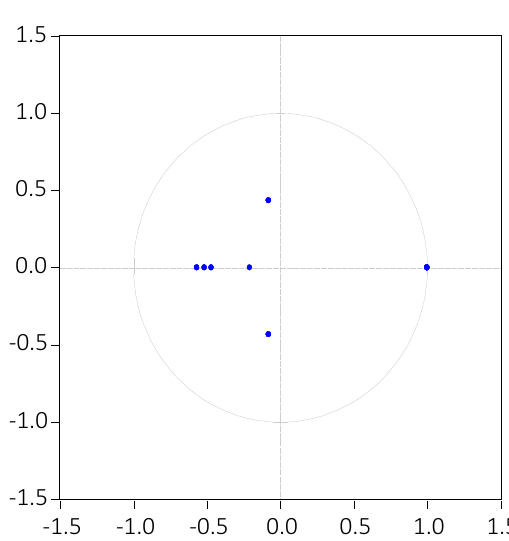
Figure 1. Test of stability of long-run relationship among variables